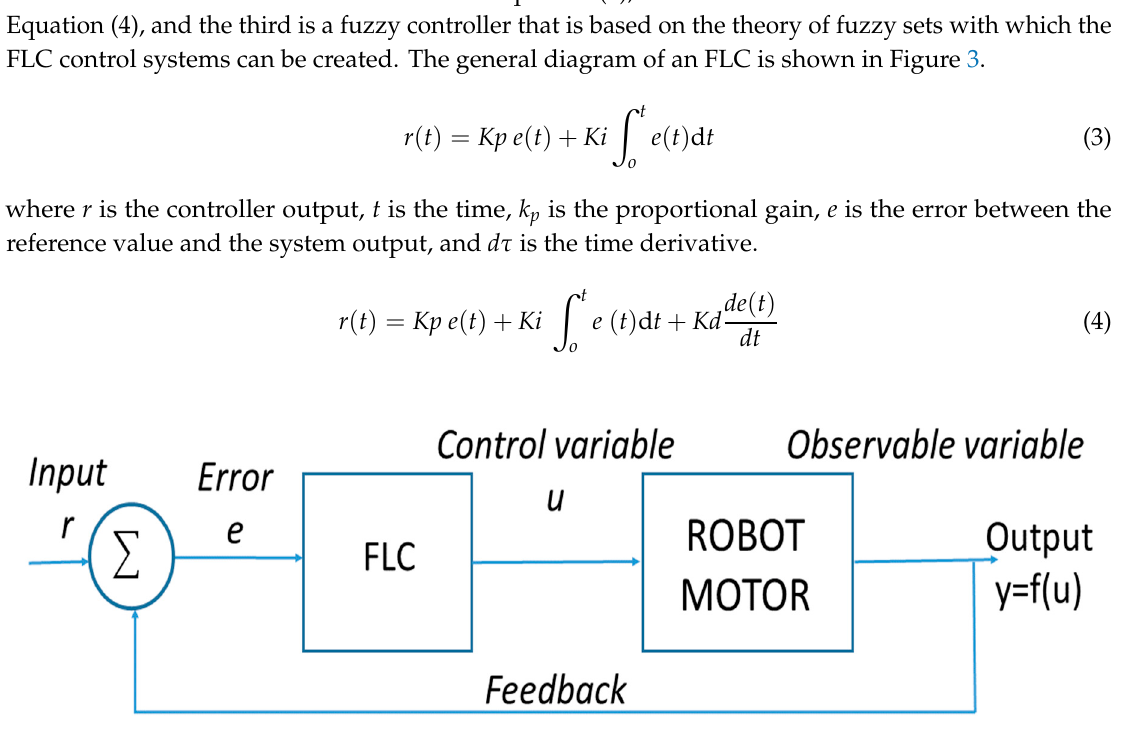
Figure 2. Closed loop controller system.